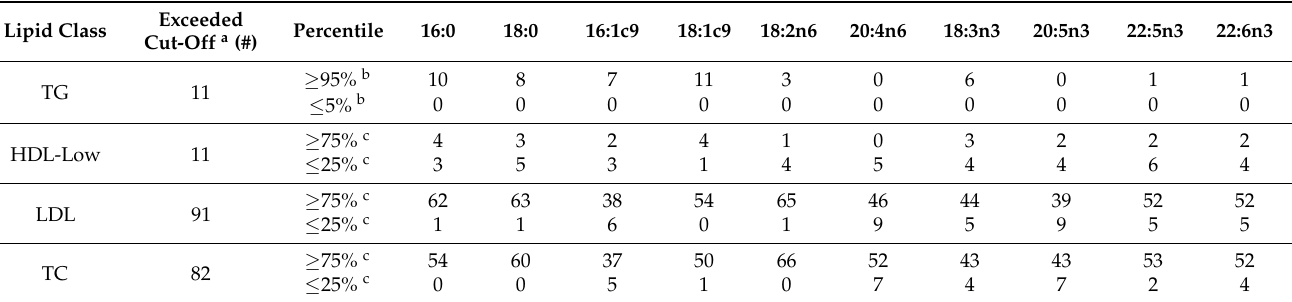
Table 6. Exploratory investigation of the upper and lower percentile fatty acid concentrations in participants who exceed risk cut-offs for lipid biomarkers. Lipid